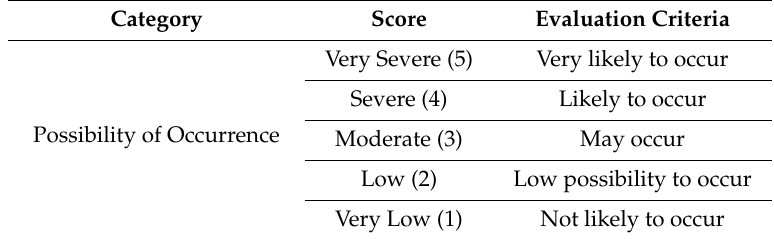
Table 1. Guidance on possibility of occurrence (Scale).